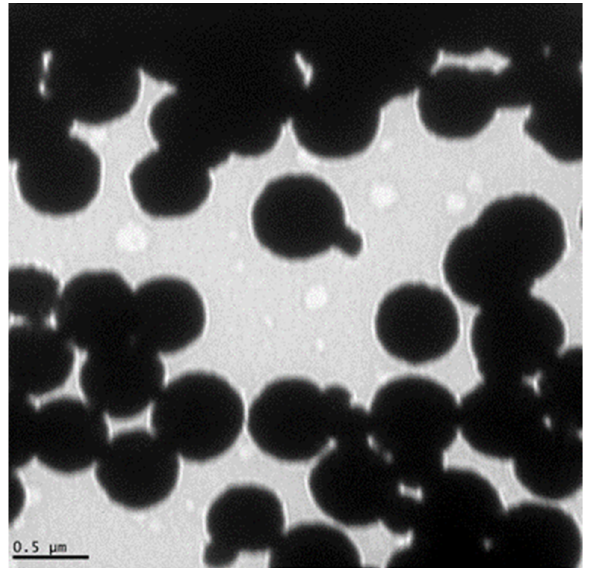
Figure 1. Transmission electron microscope (TEM) image of the glycan-coated magnetic nanoparticle clusters, with several iron oxides enclosed in the glycan polymer. Some nanoparticles are protruding from the cluster. Adopted from Bhusal et al. [21].